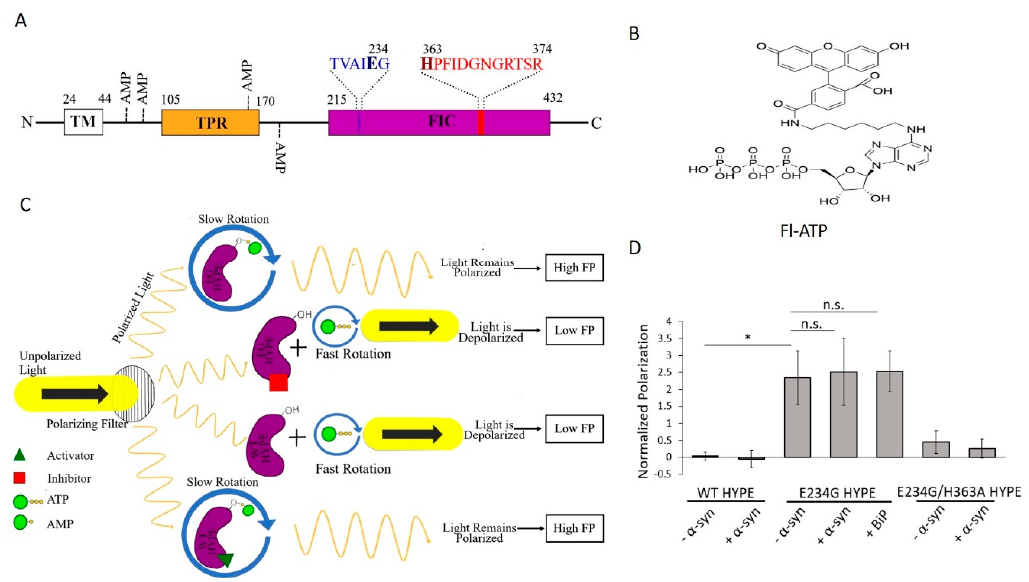
Figure 1. Fluorescence polarization (FP) of Fl-ATP monitors HYPE-mediated AMPylation. ( A ) Schematic depiction of the protein domain architecture of HYPE showing the TM (transmembrane), TPR (tetratricopeptide), and Fic (filamentation induced by cAMP) domains. AMP denotes sites of autoAMPylation. The glutamate-containing inhibitory motif and histidine-containing Fic motif are shown in blue and red, respectively. ( B ) Structure of Fl-ATP (N6-(6-amino)hexyl-ATP-5-carboxyl-fluorescein). ( C ) FP AMPylation assay design. When unattached to wild-type (WT) HYPE or compound-inhibited E234G HYPE (purple), Fl-ATP undergoes rapid rotation to depolarize plane-polarized light, and a basal FP signal is generated. Attachment of Fl-AMP via autoAMPylation (E234G HYPE or compound-activated WT HYPE) allows light to remain polarized for a high-FP signal. ( D ) Proof-of-concept of FP AMPylation assay comparing WT,